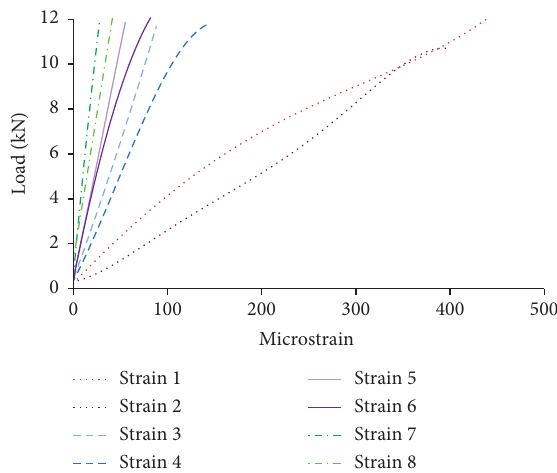
Figure 7: Plain bar-reinforced GPC pull-out load and steel strain (read from 8 gauges) relationship. Figure 8: Plain bar-reinforced OPC pull-out load and steel strain (read from 7 gauges)